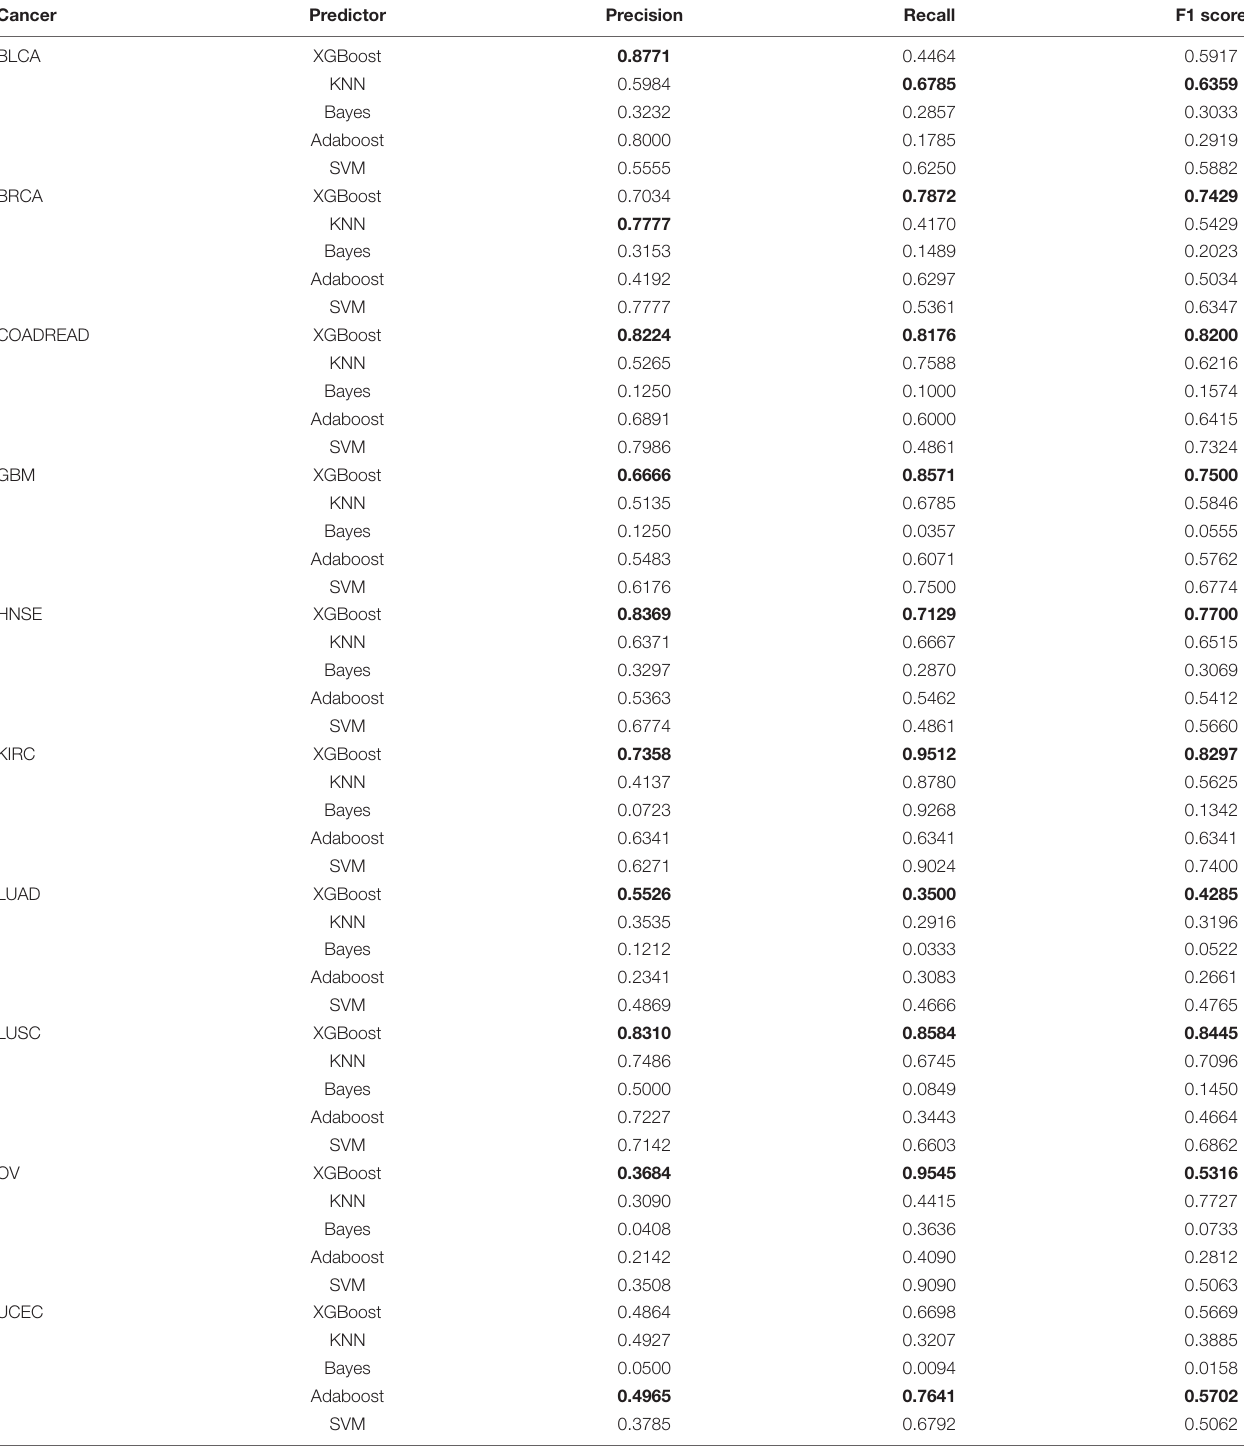
TABLE 3 | Comparison with other algorithms on independent datasets.